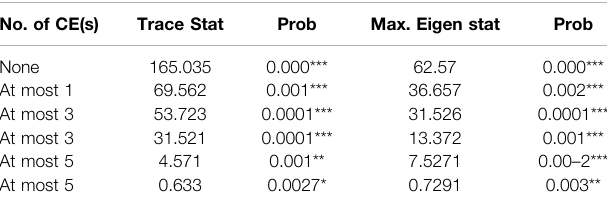
TABLE 6 | Johansen co-integration test